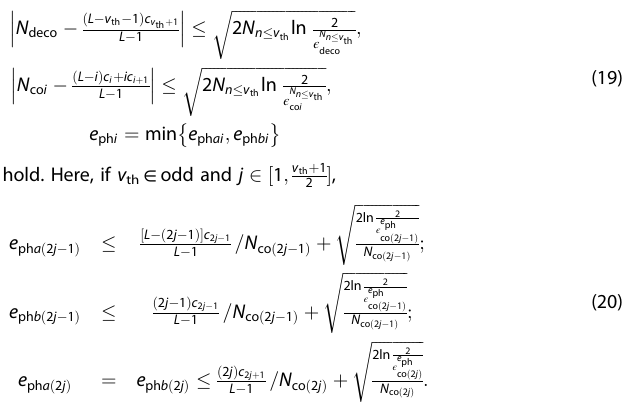
ffiffiffiffiffiffiffiffiffiffiffiffiffiffiffiffiffi 3 e src ln 1 ϵ N em PE